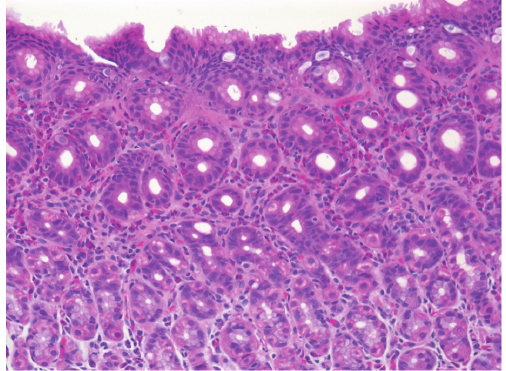
Figure 1: Moderate to severe chronic gastritis with focally increased intraepithelial